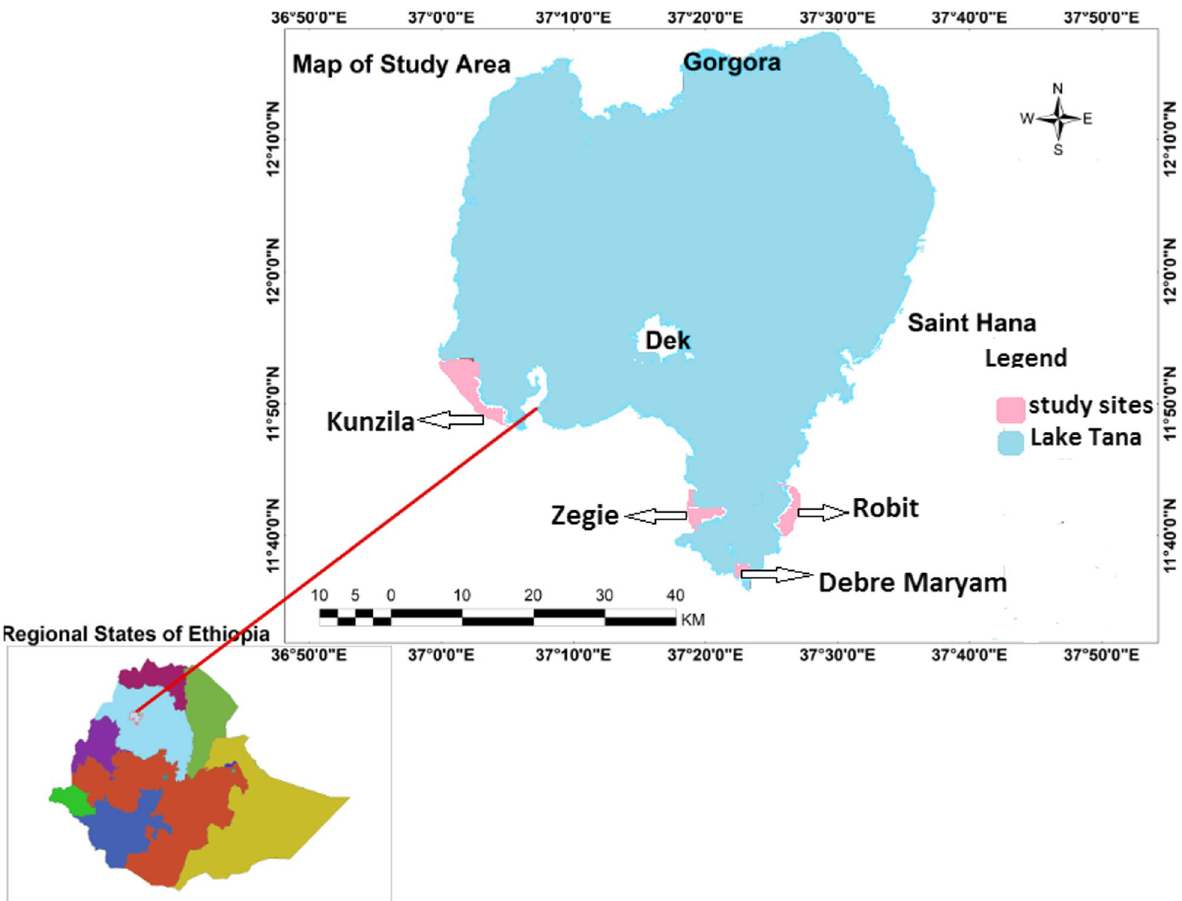
Fig. 1 Map of the study area showing four study sites in and around Lake Tana, northwest